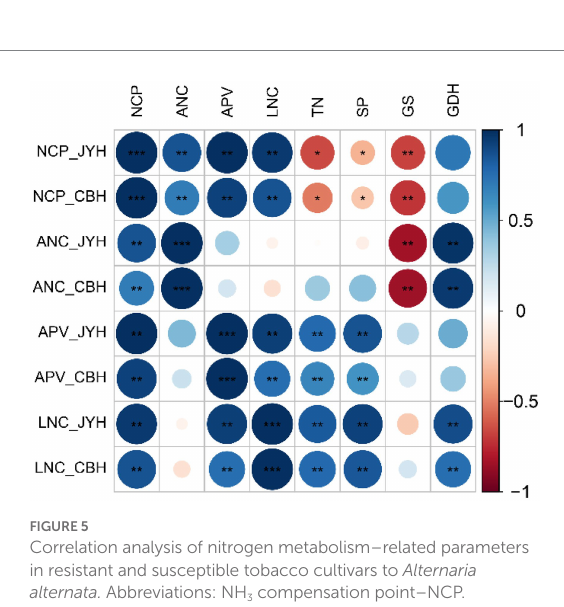
FIGURE 5 Correlation analysis of nitrogen metabolism–related parameters in resistant and susceptible tobacco cultivars to Alternaria alternata. Abbreviations: NH 3 compensation point–NCP. Apoplastic NH 4+ concentration–ANC. Apoplastic pH value–APV. Leaf tissue NH 4+ concentration–LNC. Total nitrogen content–TN. Soluble protein content–SP. GS activity–GS. GDH activity–GDH. *Significant at p ≤ 0.05 level. **Significant at p ≤ 0.01